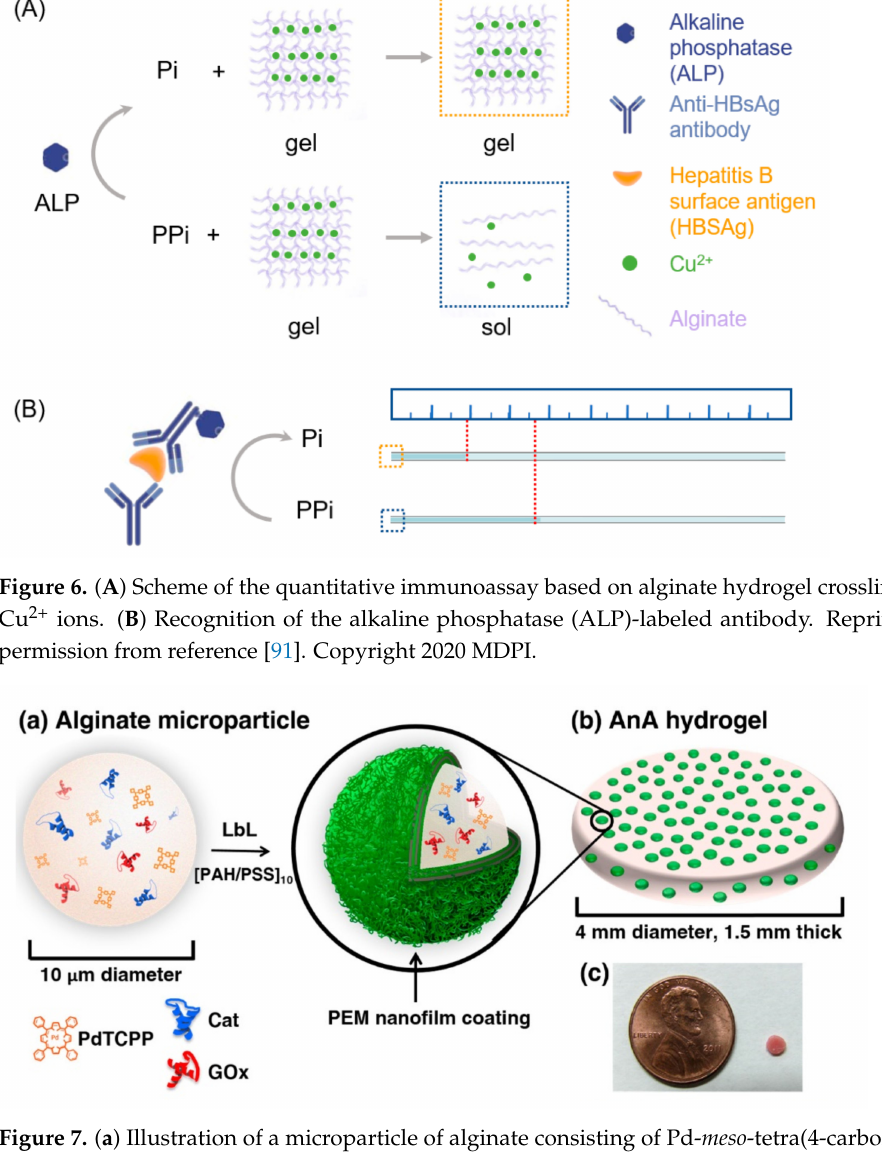
Figure 7. ( a ) Illustration of a microparticle of alginate consisting of Pd- meso -tetra(4-carboxyphenyl) porphyrin (PdTCPP), glucose oxidase (GOx) and catalase (Cat). Such microparticles are coated with 10 bilayers of poly(allylamine hydrochloride) (PAH) and poly(sodium-4-styrene sulfonate) (PSS). ( b ) AnA hydrogel with an embedded polyelectrolyte multilayer (PEM) coated alginate particles; ( c ) Photograph of alginate-in-alginate (AnA) hydrogel next to a penny. Reprinted with permission from reference [92]. Copyright 2017